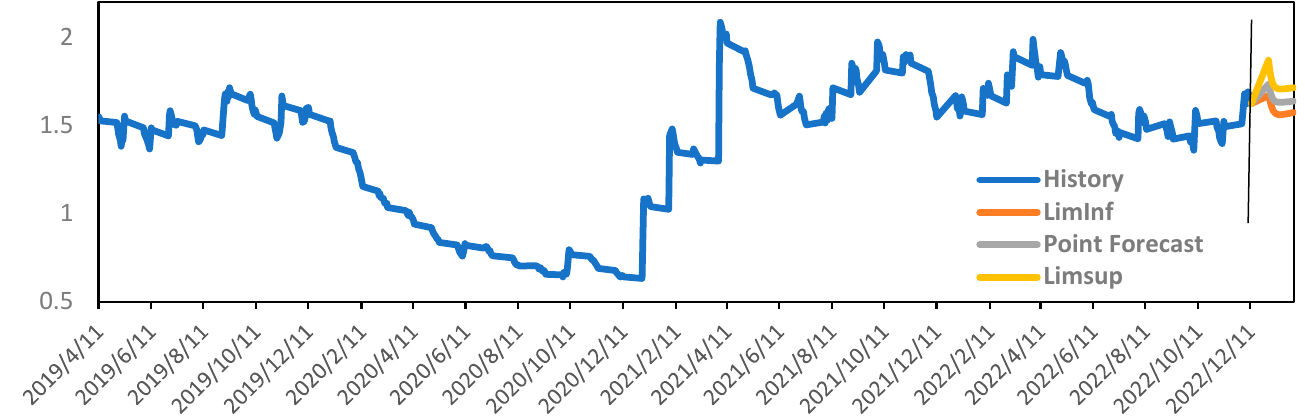
Figure 2. Out-of-Sample Forecast: Scenario 1, Volatility: Cobalt/Confidence Intervals 95% (where LimInf and Limsup are lower and upper confidence limits).